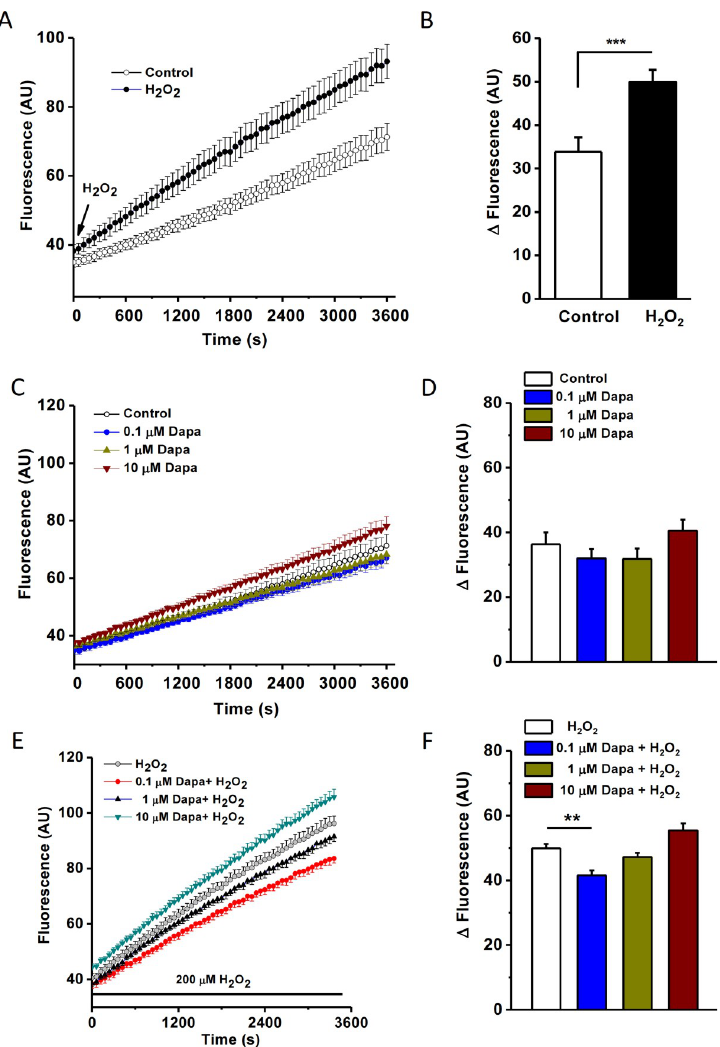
Fig 5. Cytosolic ROS production under oxidative stress and the protection by dapagliflozin. HK-2 cells were loaded with cytosolic ROS indicator, H2DCFDA (2 μ M) and the fluorescence intensity was dynamically monitored using FlexStation at an excitation wavelength of 492 nm and an emission wavelength of 520 nm. Reads were sampled every 60 seconds. A. The time course of fluorescence intensity in control and H 2 O 2 -treated groups. B, Change of cytosolic ROS fluorescence in 60 min for the control (without H 2 O 2 ) and H 2 O 2 groups ( n = 5, ��� P < 0.001). C, Effects of dapagliflozin (Dapa) on cytosolic ROS production under normal conditions. D, Mean ± SEM data for the change of fluorescence in HK-2 cells within 60 min. E, Time course of cytosolic ROS indicator fluorescence for the cells treated with H 2 O 2 (200 μ M) and different concentrations of dapagliflozin. F, Mean ± SEM data for the delta fluorescence changes in 60 min ( n = 5 for each concentration). One-way ANOVA with Bonferroni post hoc test was used. �� P <